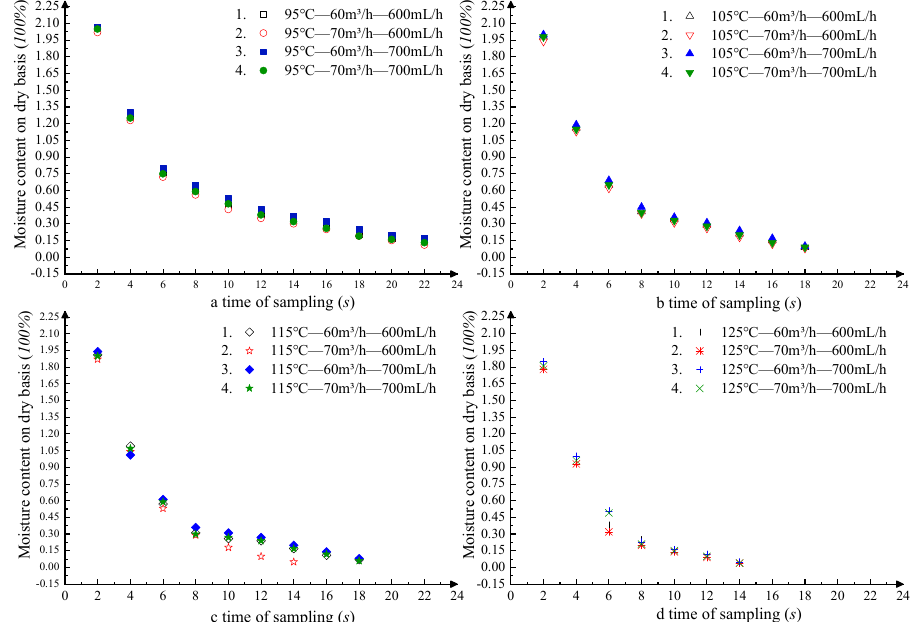
Figure 9. Moisture content of yeast under different test parameters with time.